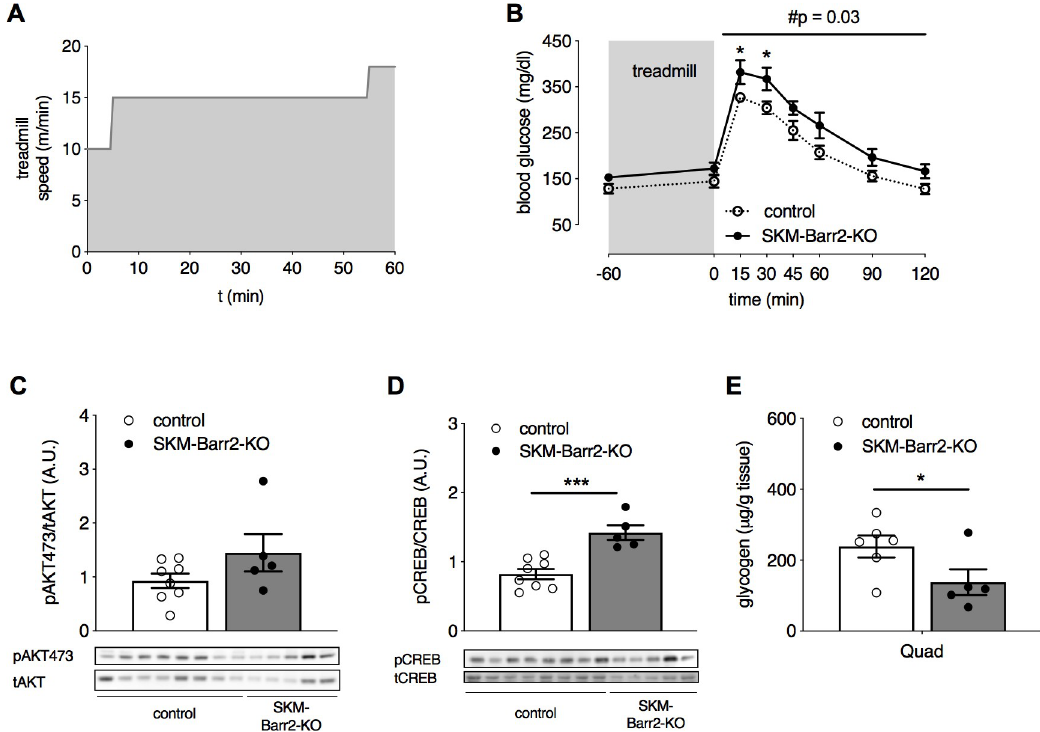
Fig 4. SKM-Barr2-KO mice show increased exercise-induced glycogen breakdown and impaired post-exercise glucose tolerance. Male adult SKM-Barr2-KO and control mice consuming normal chow were run on a treadmill for 1 h following the protocol illustrated in (A). (B) GTT (2 g/kg glucose i.p.) performed after the treadmill exercise. (C-E) Western blotting studies and SKM glycogen content. Mice were subjected to the experimental protocol shown in (A), injected with glucose (2 g/kg glucose i.p.), and then euthanized for the isolation of SKM tissues. (C, D) Western blotting studies. (E) SKM glycogen content. Data are presented as mean ± SEM (5–8 mice per group). � P < 0.05, ��� P < 0.001 (Student’s unpaired t-test); #P = 0.03 (2-way-ANOVA). Quad, quadriceps